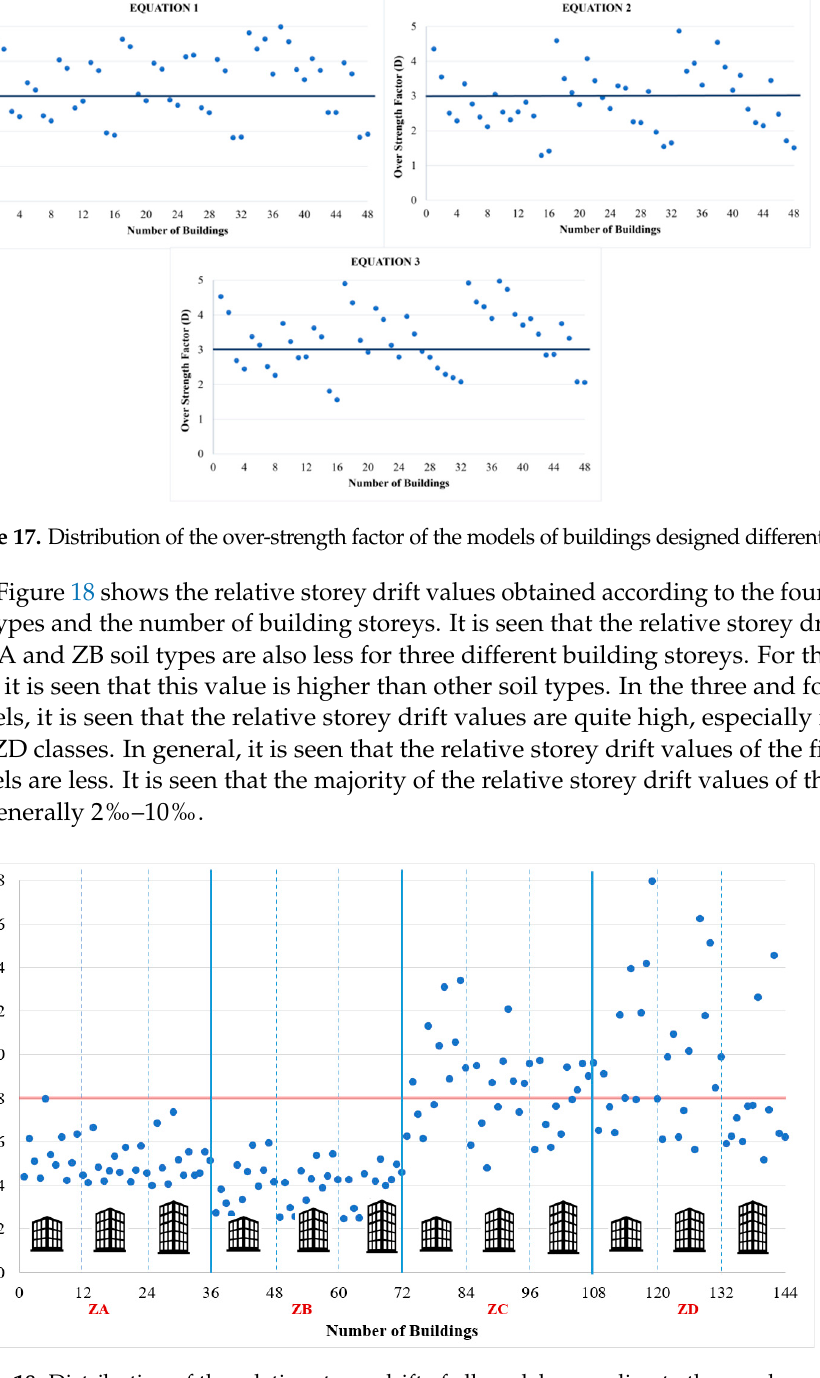
Figure 18. Distribution of the relative storey drift of all models according to the number of buildings and soil types.